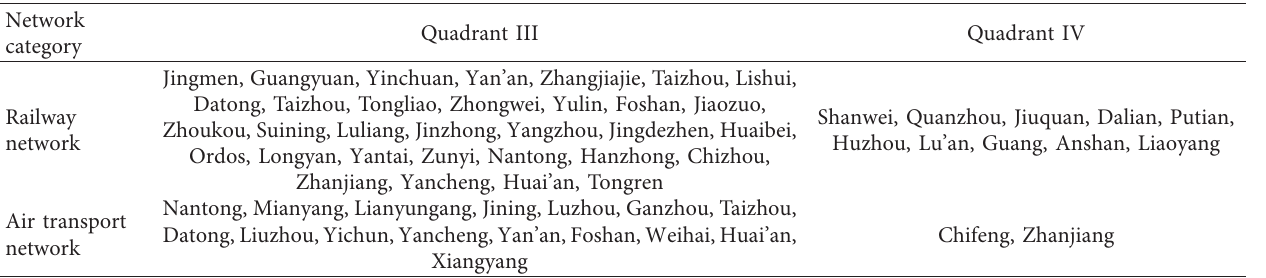
Table 6: Cities with poor matching in China railway and air transport networks.